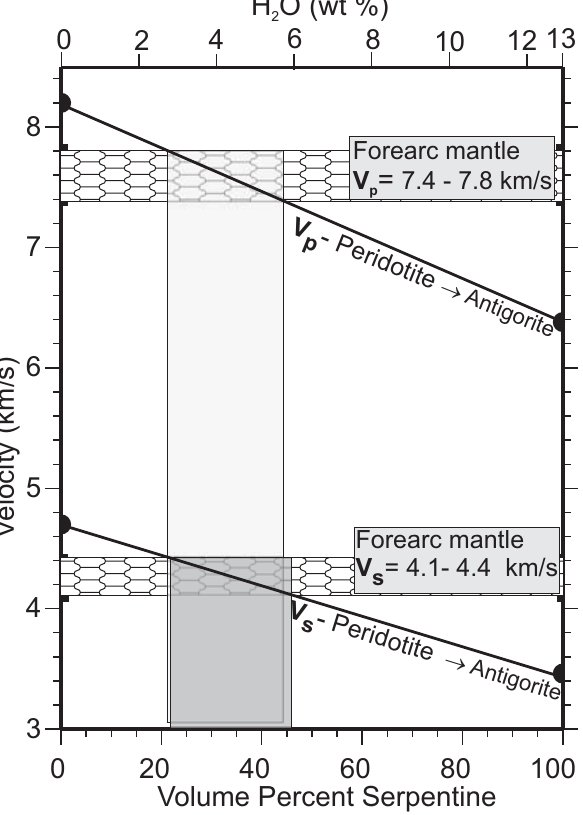
Fig. 5. Plot of peridotite-antigorite assemblage velocity versus volume percent serpentinization (velocity of antigorite taken from (Christensen, 2004)). The observed range of P- and S-wave velocity is shown by the hachured region. The vertical shaded regions show the volume serpentinization corresponding to the observed P and S velocity range.